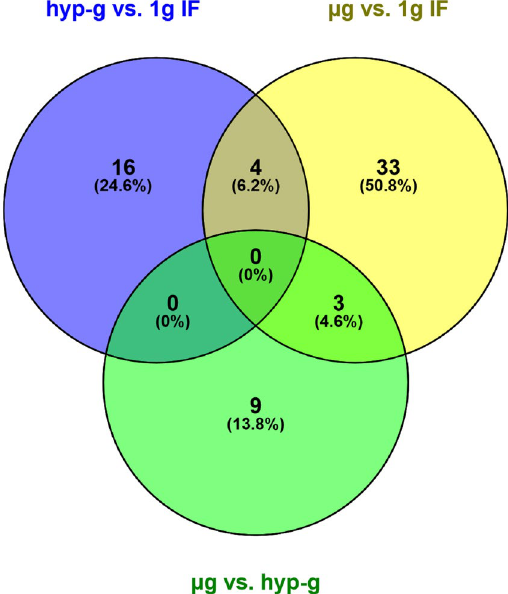
Figure 2. Venn diagram of overlapping and non-overlapping expression of significantly differentially expressed genes due to altered gravity conditions during the parabolic flight experiments. 1 g in-flight (1 g IF), 1.8 g hypergravity (hyp-g), and microgravity ( µ g). Venn diagram was constructed using Oliveros, J.C. (2007–2015) Venny, http://bioinfogp.cnb.csic.es/tools/venny/index.html.